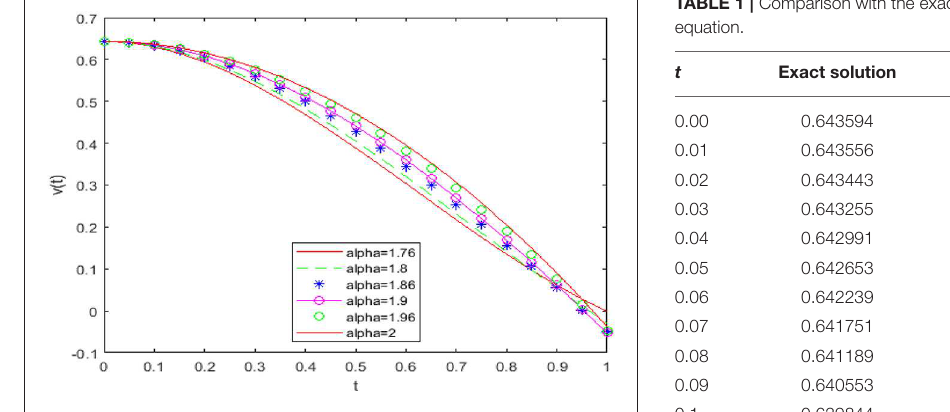
FIGURE 1 | Numerical solutions at α 1.76, 1.8, 1.86, 1.9, 1.96, and 2 for = case 1 at e 1 and f 1. = =